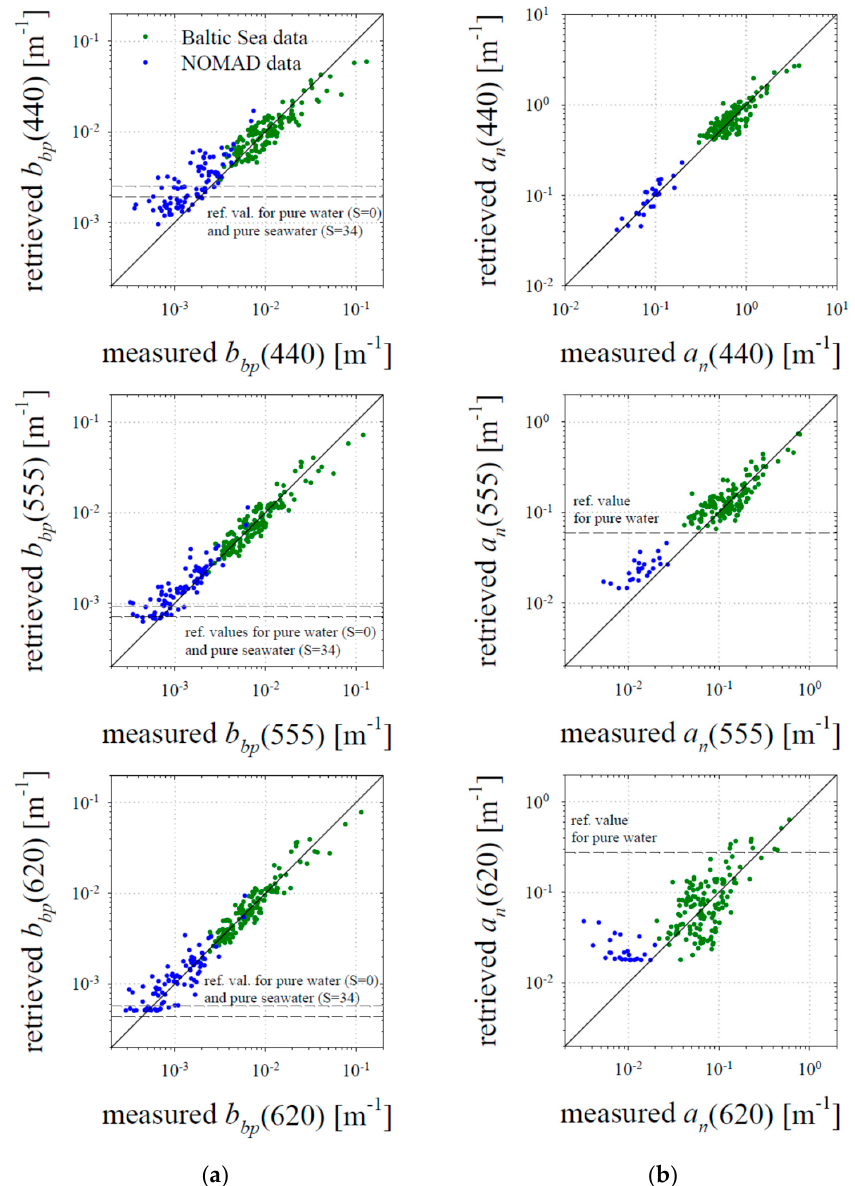
Figure 12. Comparison of optical coefficients retrieved using the new algorithm with the measured values for three spectral bands: 440, 555 and 620 nm: ( a ) comparison for the backscattering coefficient of particulate matter b bp ; ( b ) comparison for the absorption coefficient of the sum of dissolved and suspended constituents a n .